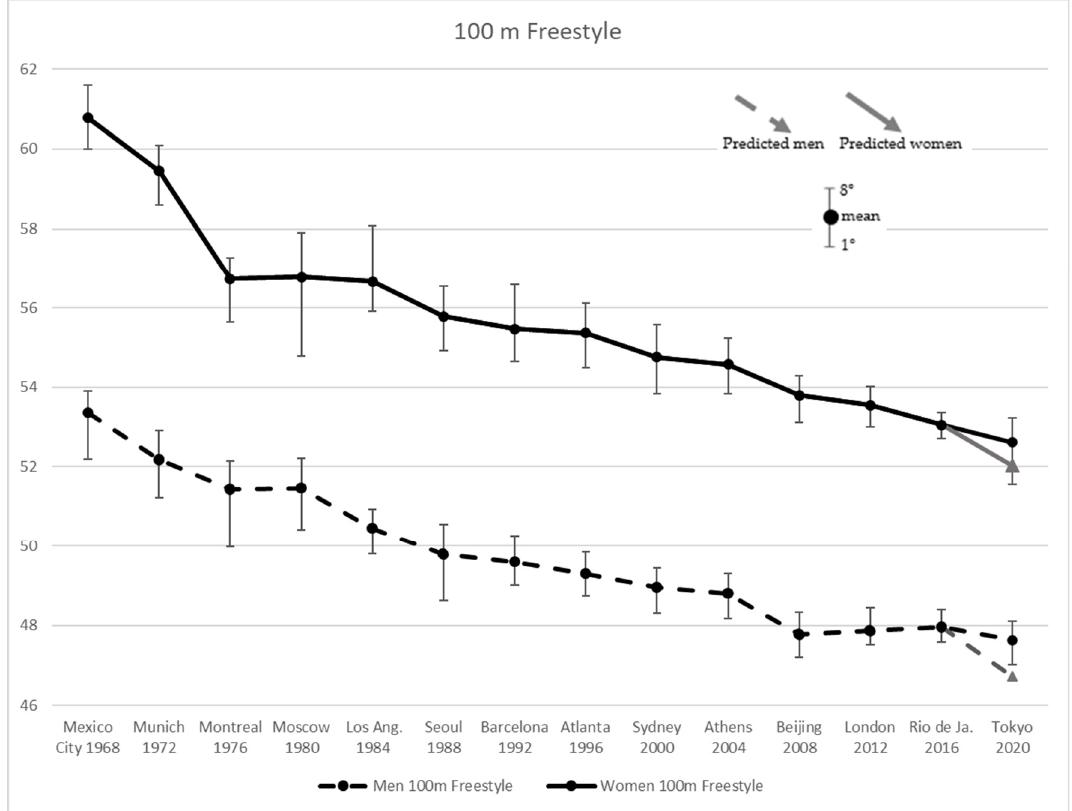
Figure 1. Men’s and Women’s 100 m Freestyle results from Mexico City 1968 to Tokyo 2020 Olympic Games, and the values predicted for the latter.